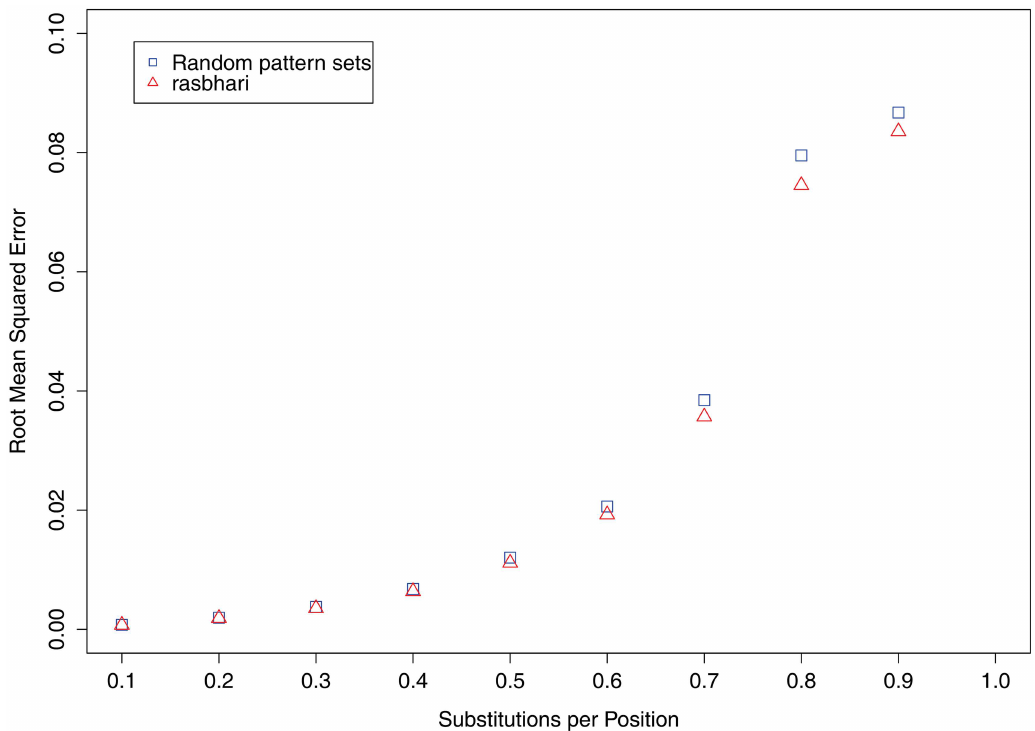
Fig 2. Accuracy of phylogenetic distance estimates based on different pattern sets. Nine sets of DNA sequence pairs were simulatedwith distances d between 0.1 and 0.9 substitutions per position. Distances were estimated based on the number N of spaced-word matches between them, using the alignment-free method publishedin [34]. We used two types of underlying pattern sets, ( a ) pattern sets generated with rasbhari , minimizing the variance of N , and ( b ) randomly generatedpattern sets. The root mean square error of the estimated distances is plotted against the ‘real’ distances d